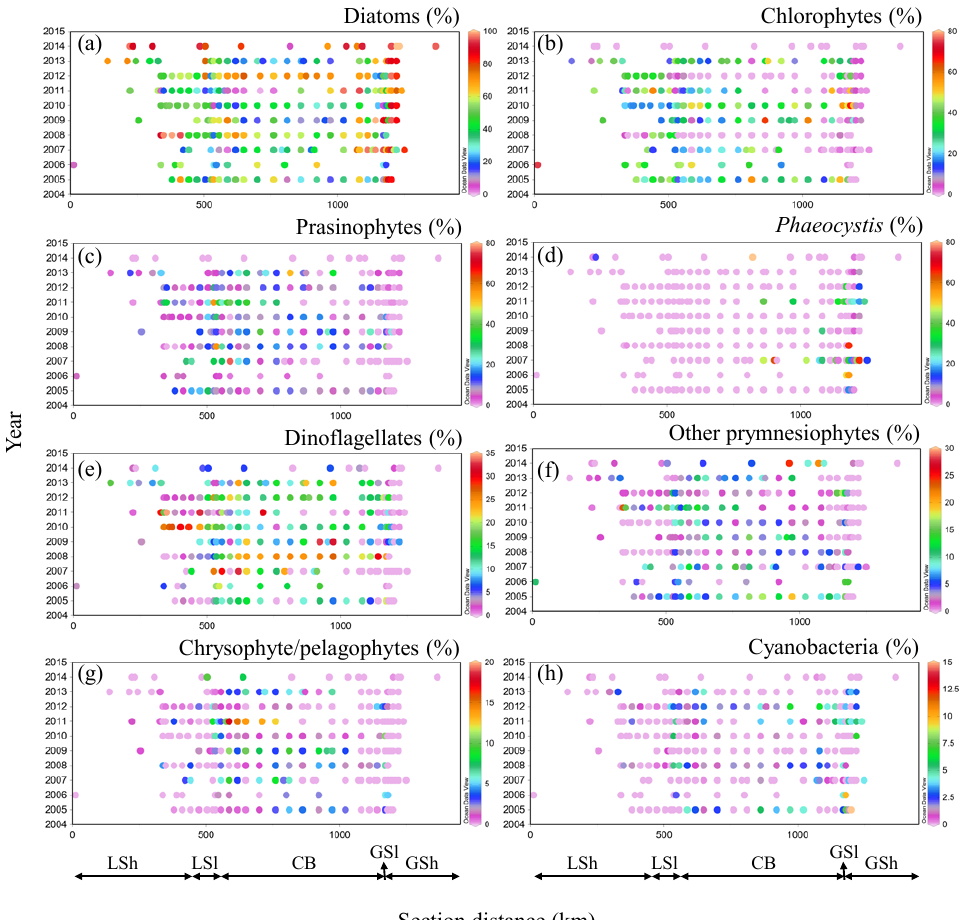
Figure 3. Relative contribution (%) of chlorophyll a from distinct phytoplankton groups at each station from 2005 to 2014 along the section distance from Labrador coast represented in Fig. 2a (star symbol). LSh, Labrador Shelf; LSl, Labrador Slope; CB, Centre Basin; GSl, Greenland Slope; GSh, Greenland Shelf. Note the distinct scales for each